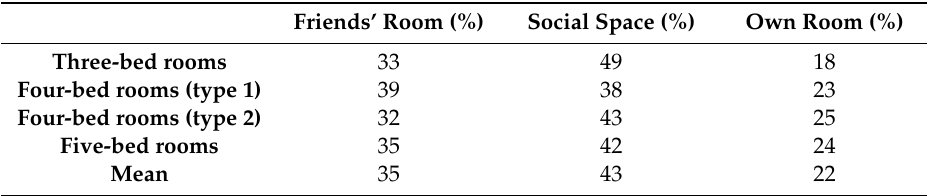
Table 5. Probability of finding residents in the nursing